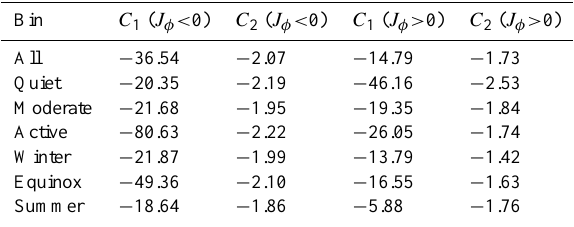
Table 2. Coefficients C 1 and C 2 resulting from the fitting of Eq. (6) into the data displayed in Figs. 13 and